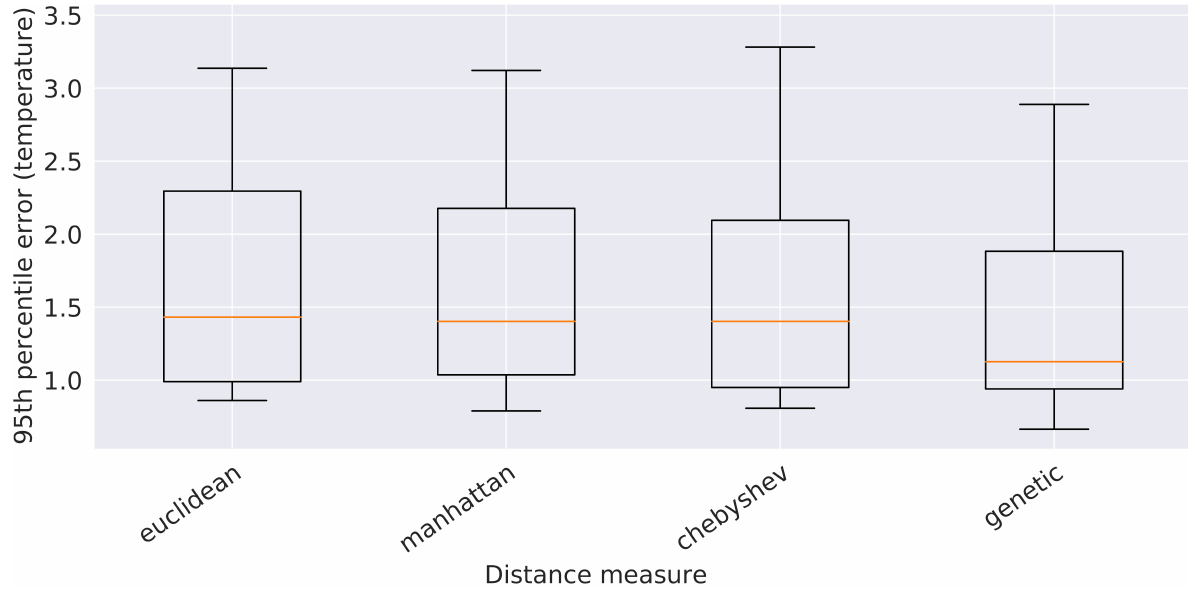
Figure 11. Boxplots of the 95th percentile of the error provided by the XGBoost models built on the 5 spatial distances considered in this